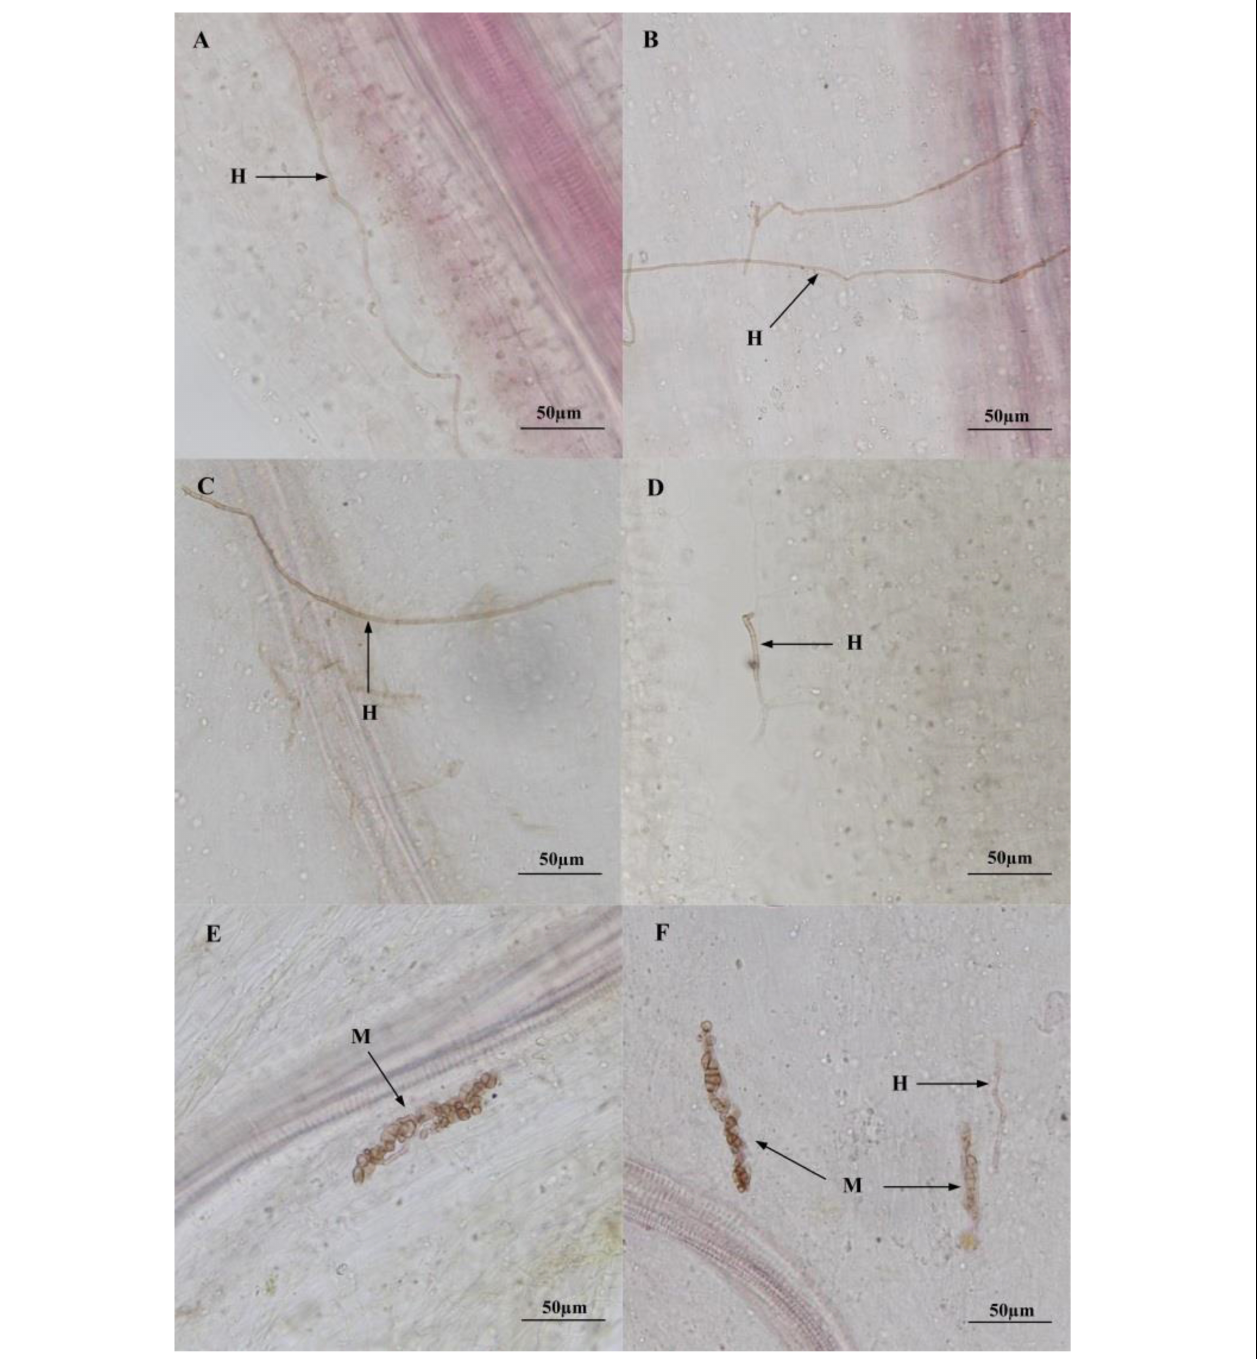
FIGURE 3 | Colonization of dark septate endophyte (DSE) strains in the roots of liquorice plant 3 months after inoculation. (A–F) Indicate roots inoculated with A. vagum , P. putaminum , A. vagum + sterilized residue, P. putaminum + sterilized residue, A. vagum + unsterilized residue, P. putaminum + unsterilized residue, respectively. Arrows indicate: H = DSE hyphae, M = DSE microsclerotia.